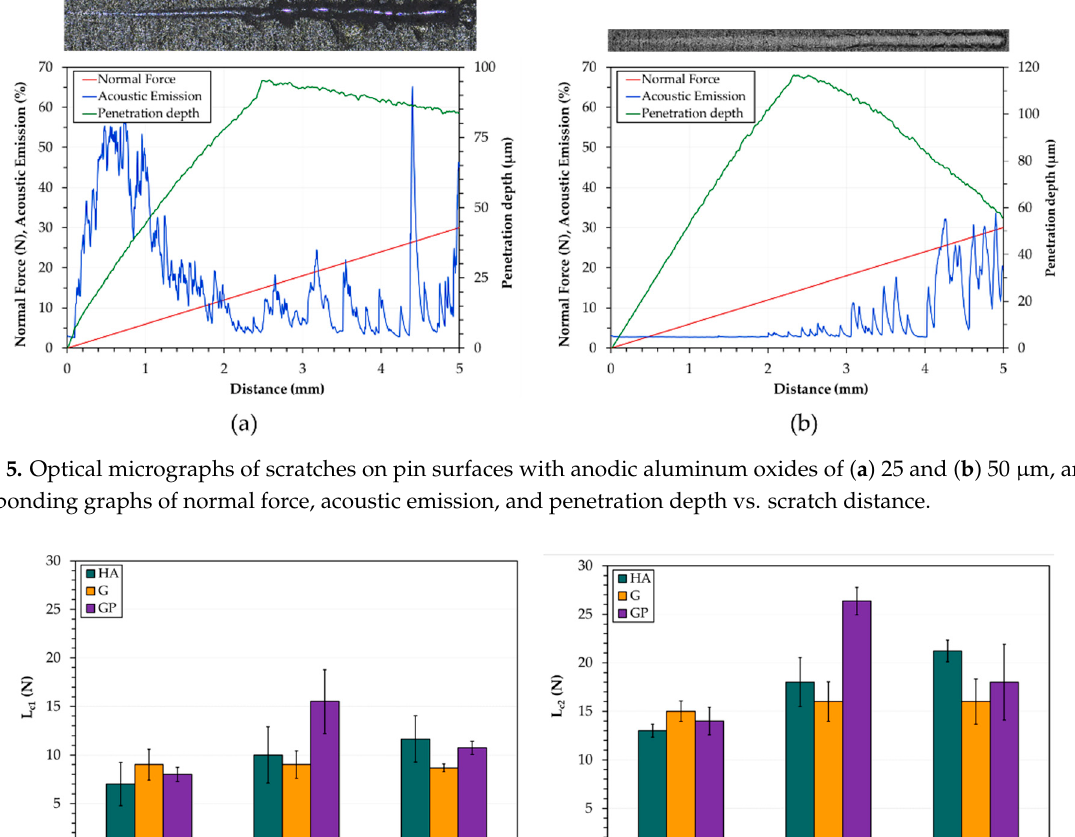
Table 2. Mean values ± standard deviations of the roughness parameters (R a and R z ) and Vickers microhardness (HV0.01) for all anodizing treatments (HA, G, and GP) and thicknesses of AAO layers (25, 50, and 100 μ m).